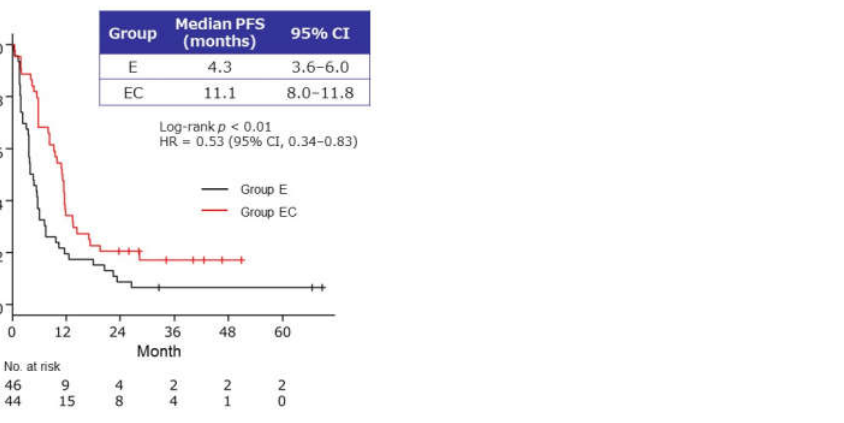
Figure 4. Kaplan–Meier curves of time to failure of strategy (TFS) from randomization in patients who received bevaci- zumab–paclitaxel reinduction therapy after maintenance therapy with endocrine therapy alone (group E) or endocrine therapy plus capecitabine (group EC). CI, confidence interval; E, endocrine therapy alone; EC, endocrine therapy plus capecitabine.